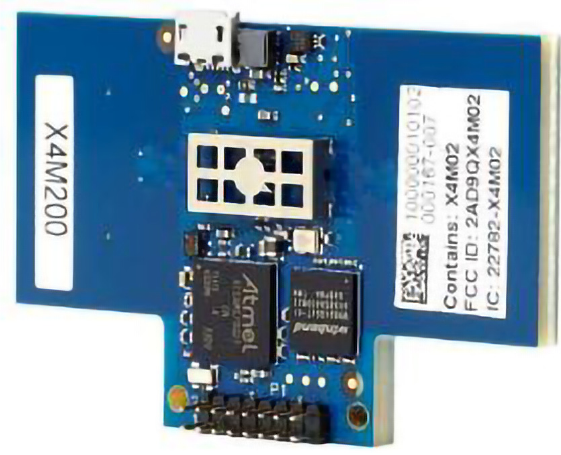
Figure 2. XeThru X4M200 UWB RADAR sensor.